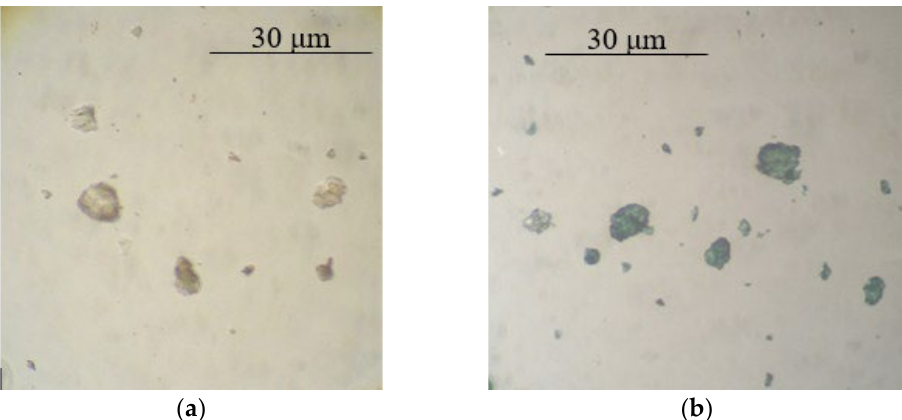
Figure 1. Micrographs of bentonite ( a ) and core/shell pigment with a bentonite core ( b ) (20 wt.% of PANi, sulfuric acid used as a dopant).